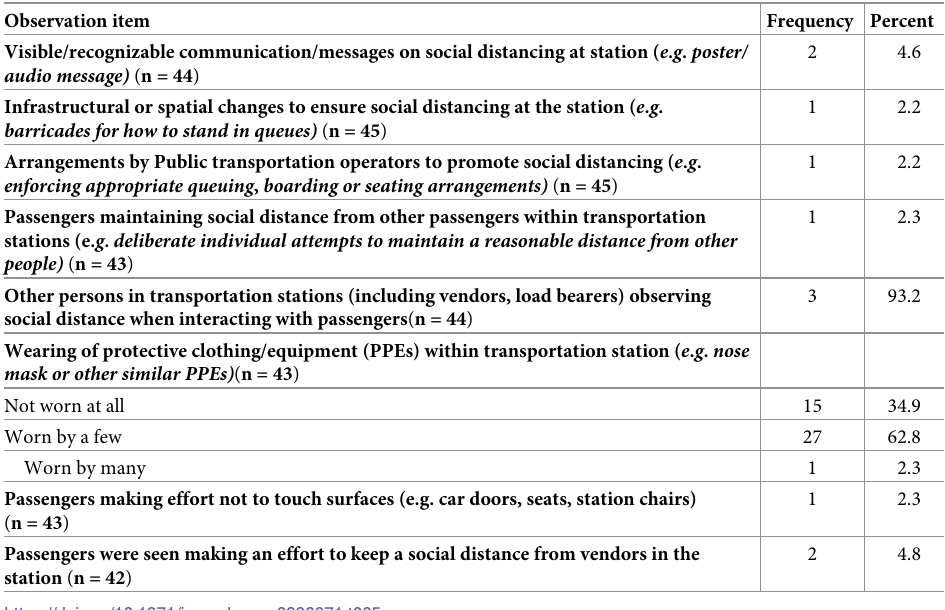
Table 5. Social distancing at public transportation stations in the Greater Accra Region of Ghana. Observation item Frequency Percent Visible/recognizable communication/messages on social distancing at station ( e . g . poster/ audio message) ( n = 44 ) Infrastructural or spatial changes to ensure social distancing at the station ( e . g . barricades for how to stand in queues) ( n = 45 ) Arrangements by Public transportation operators to promote social distancing ( e . g